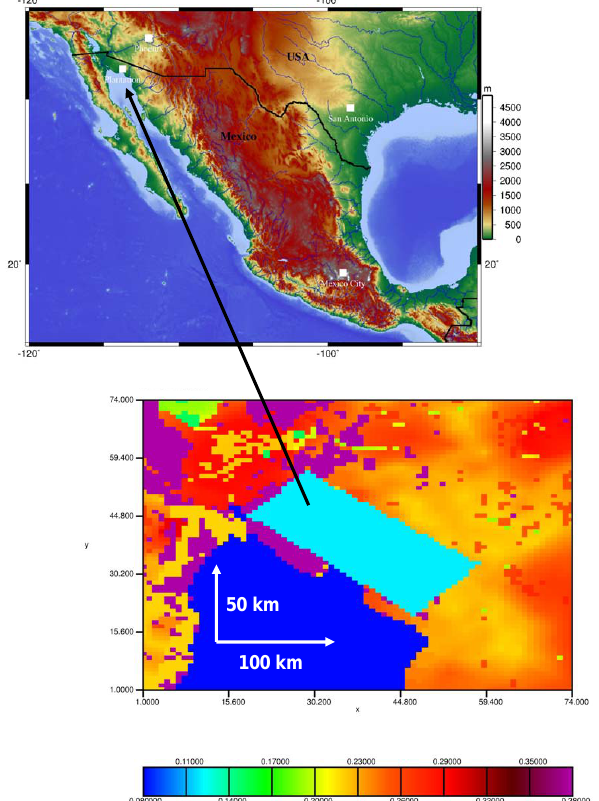
Fig. 4b. Upper panel: location of the plantation in the Sonora. Bot- tom panel: 2-D plots of the reduction in albedo caused by Jatropha Fig.4b Upper panel: Location of the plantation in the Sonora. Bottom panel: 2D plots of the 20 curcas plantations in the Sonora. reduction in albedo caused by Jatropha curcas plantations in the Sonora. 21